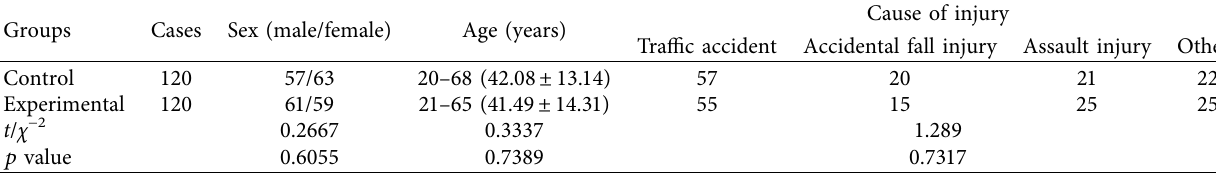
Table 1: Comparison of general information between the two groups.